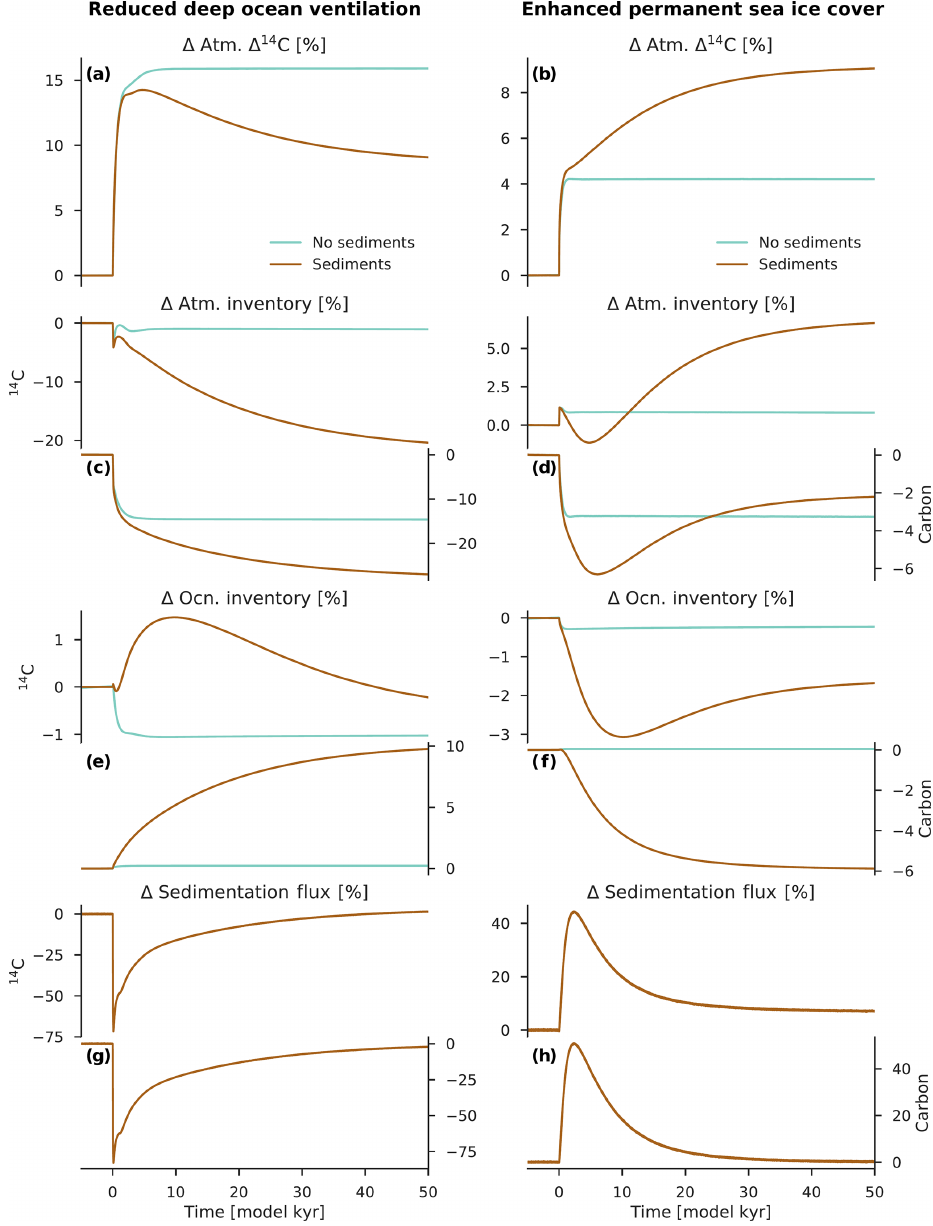
Figure 5. Changes in carbon reservoir sizes and the sedimentation flux for the scenarios “reduced deep ocean ventilation” (a, c, e, g) and “enhanced permanent sea ice cover” (b, d, f, h) . The change in atmospheric (cid:49) 14 C is also shown (a, b) . Anomalies are expressed here as differences relative to the preindustrial steady state (in percent). Turquoise lines show the model results using configuration OCN-LND (without sediments), and brown lines are configuration ALL (with sediments). The y axis on the left-hand side of each panel refers to changes in the 14 C inventory, whereas the y axis on the right-hand side of each panel refers to changes in the carbon inventory or